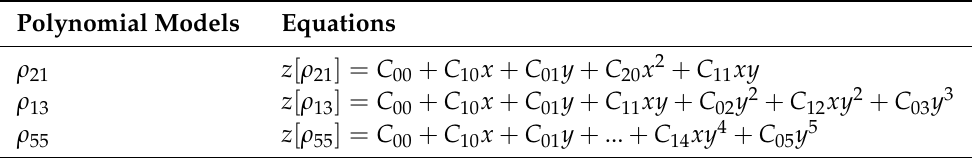
Table 3. Examples of polynomial models for